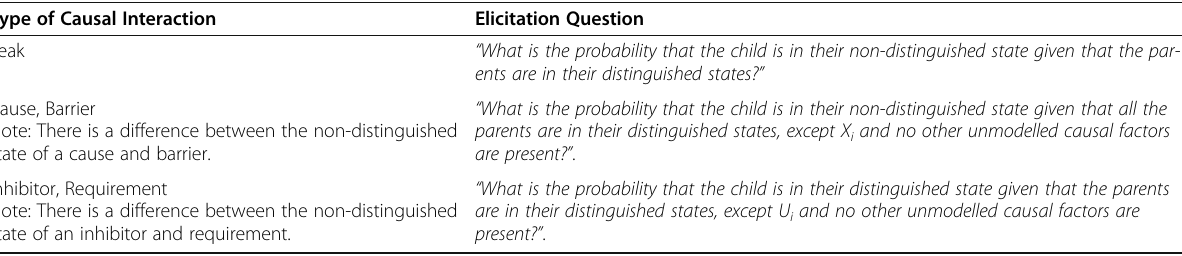
Table 1 Causal Interactions and their Corresponding Elicitation Questions in the DeMorgan Model Type of Causal Interaction